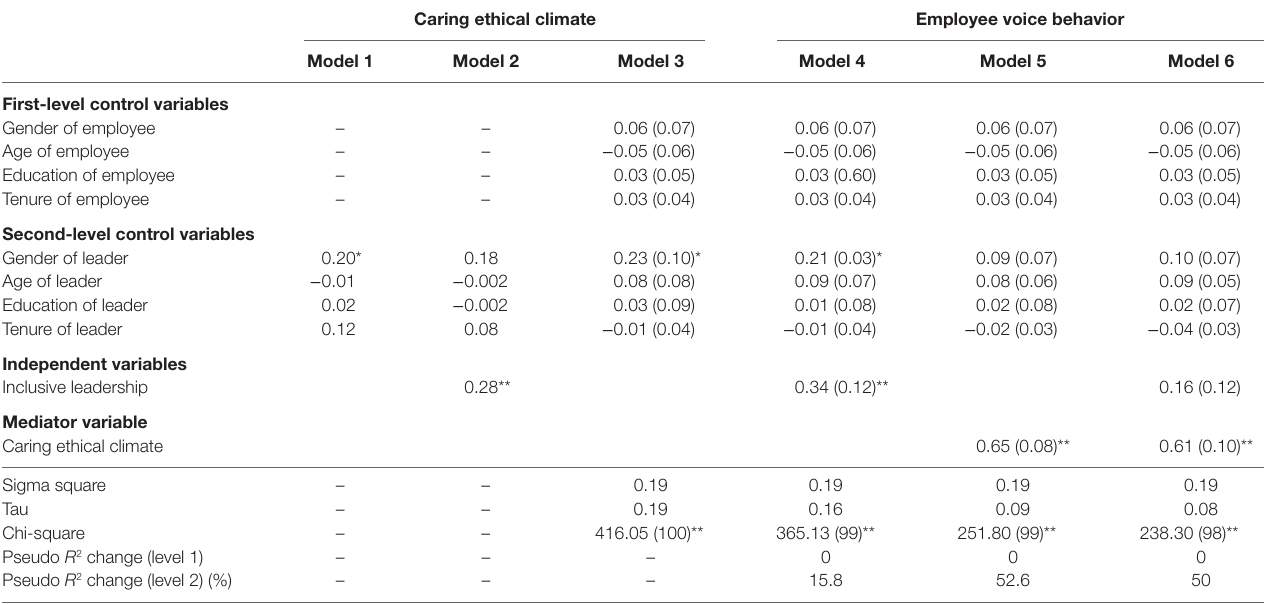
TaBle 6 | Inspection of the intermediary cross-level effect of caring ethical